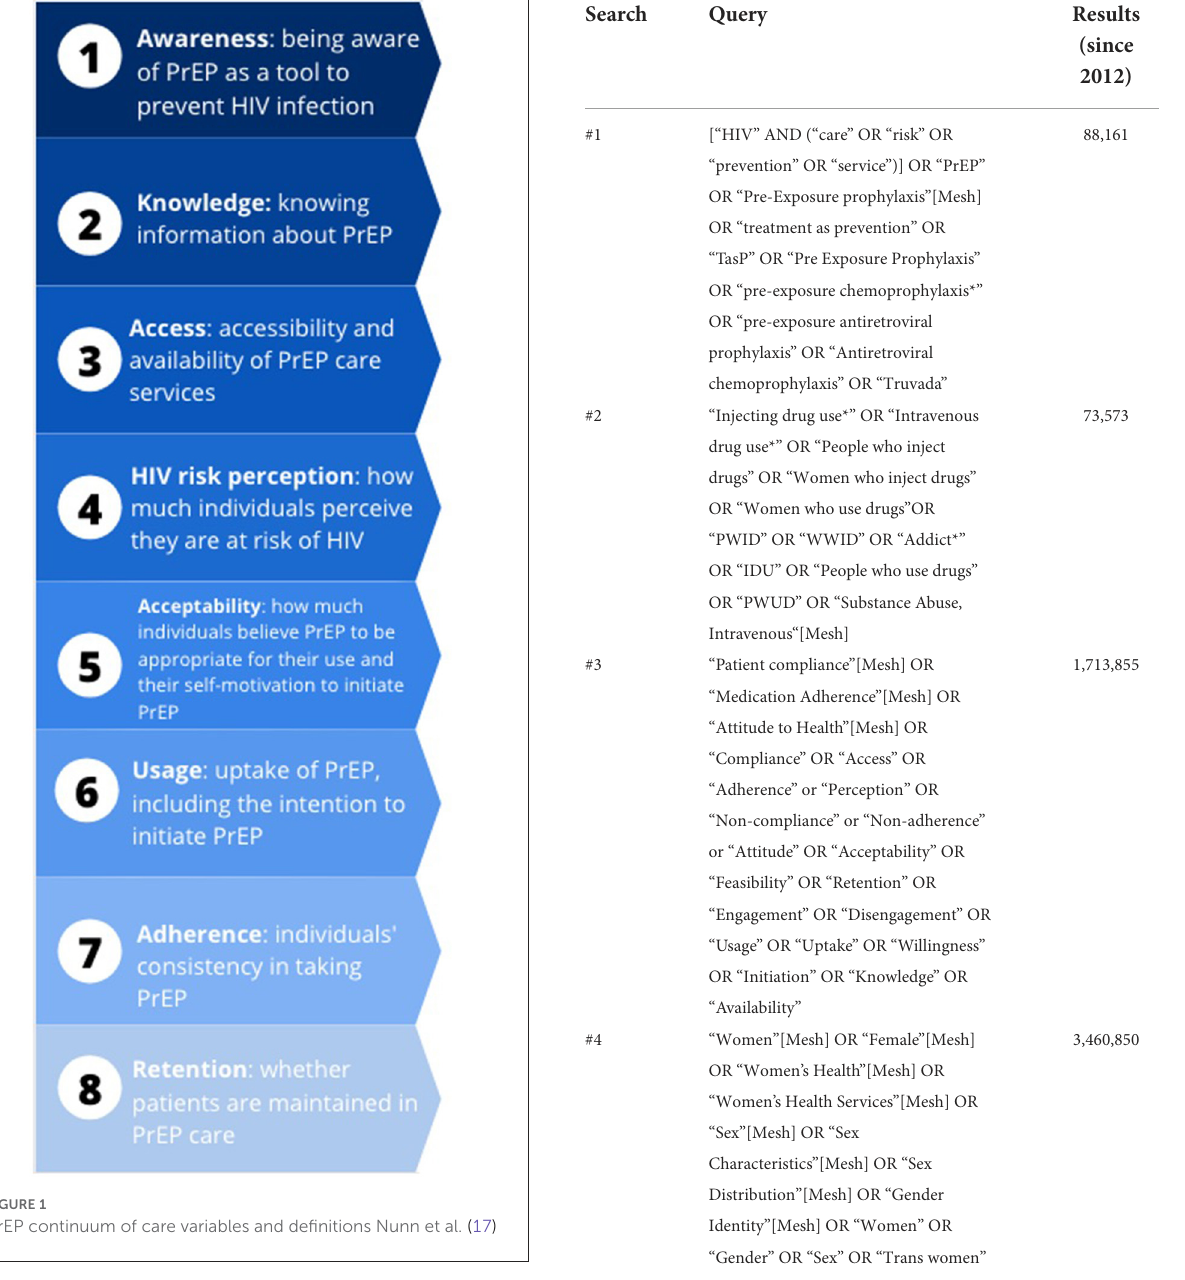
TABLE 1 Search strategy (PubMed 17 June